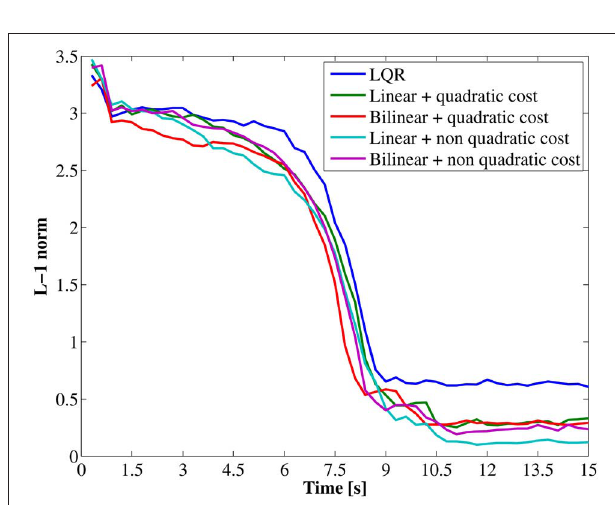
FIGURE 13 | Trajectories of the L-1 norm between the current and goal states.